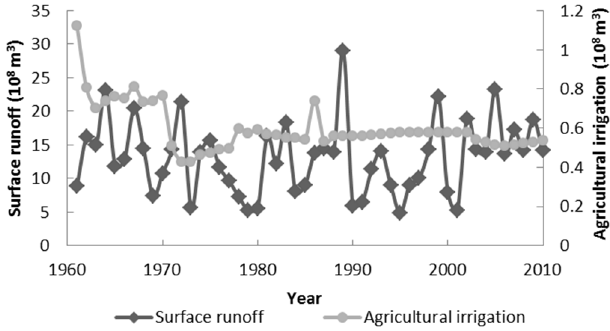
Figure 8. Total surface runoff and agricultural irrigation in the Qinghai Lake catchment.